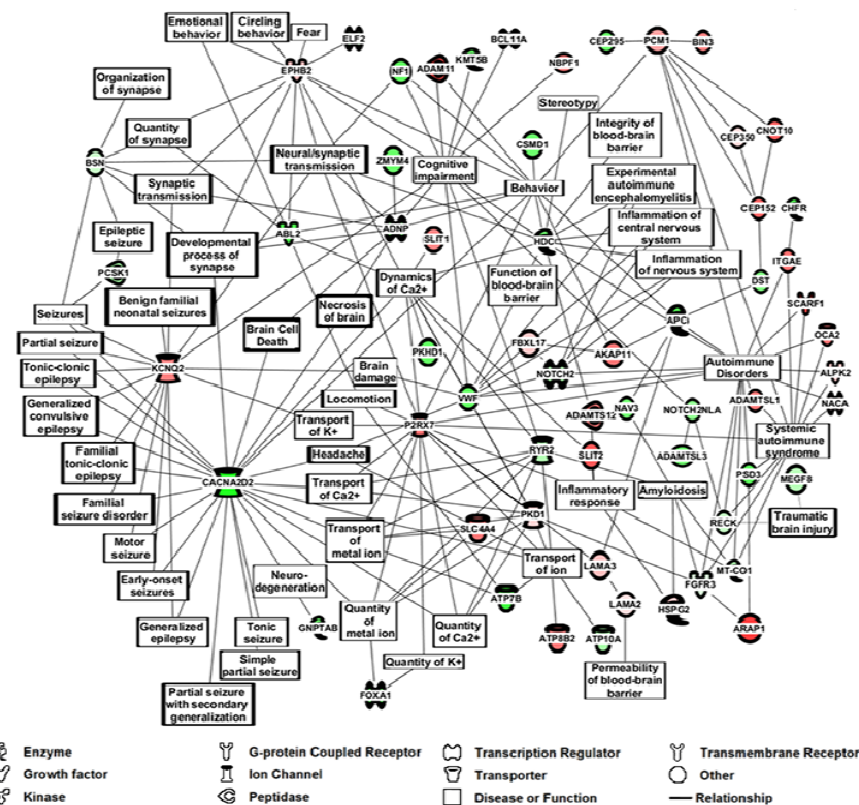
Figure 4. IPA m / z Range MS / MS Serum Data Analysis for Epilepsy Patients vs. Controls using top Figure 4. IPA m/z Range MS/MS Serum Data Analysis for Epilepsy Patients vs. Controls using top 100 Peptide / Proteins from Tables 3 and 4. Ingenuity Pathway Analysis (IPA), (Qiagen, Inc.) of the 100 100 Peptide/Proteins from Table 3 and Table 4. Ingenuity Pathway Analysis (IPA), Qiagen, Inc.) of peptides / proteins exhibited in Tables 3 and 4 having a 2 × di ff erence in positive sera number between the 100 peptides/proteins exhibited in Table 3 and Table 4 having a 2× difference in positive sera epilepsy and controls, and a 1.5 × di ff erence in MS / MS “hit” (single peptide identification) ratio between number between epilepsy and controls, and a 1.5× difference in MS/MS “hit” (single peptide the two groups. The protein function legend is at the bottom of the identification) ratio between the two groups. The protein function legend is at the bottom of the figure.